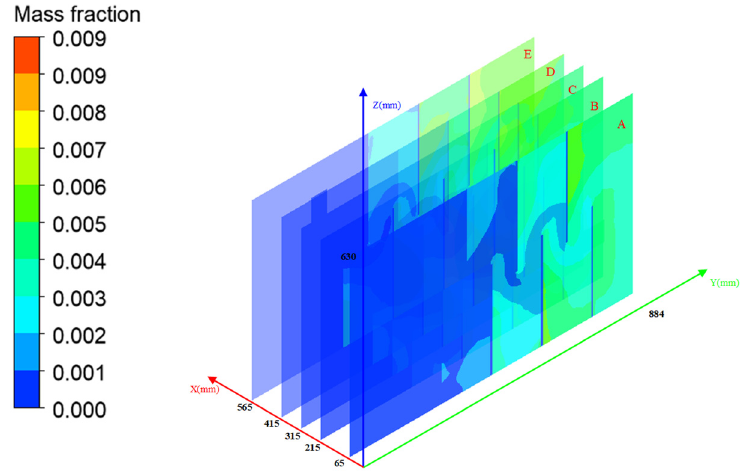
Figure 10. Position of each section and contour plot of tracer concentration.